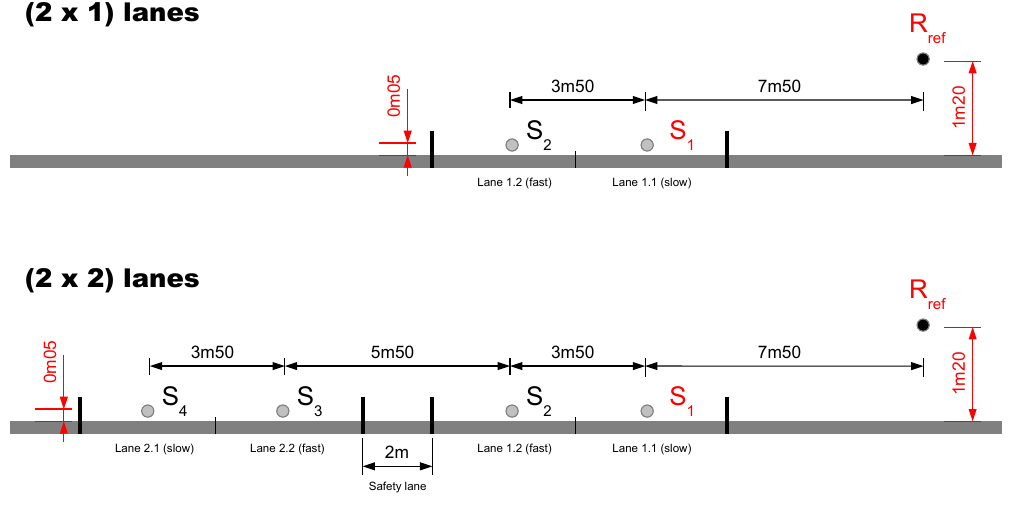
Figure 4. Road configurations: (2 × 1) lanes ( upper ) and (2 × 2) lanes ( lower ). Location of the sound sources S 1 / S 2 on a 2-lanes road, and S 1 / S 2 and S 3 / S 4 on a 4-lanes road. The reference receiver is located at position R ref